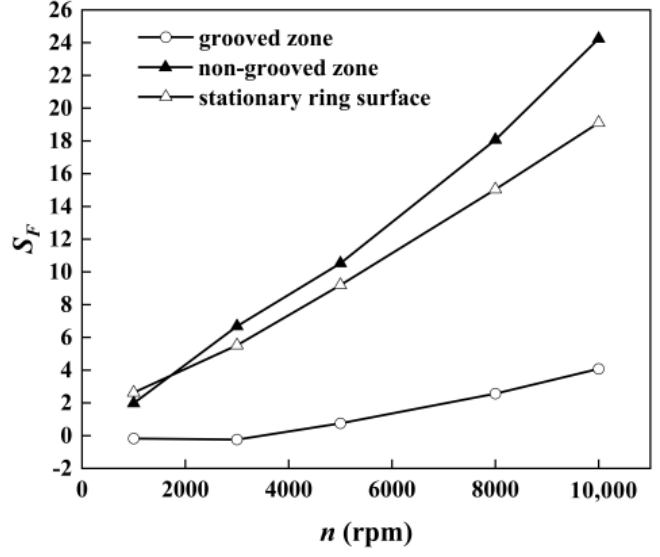
Figure 16. Relationship between the S F of different parts and the rotating speed.